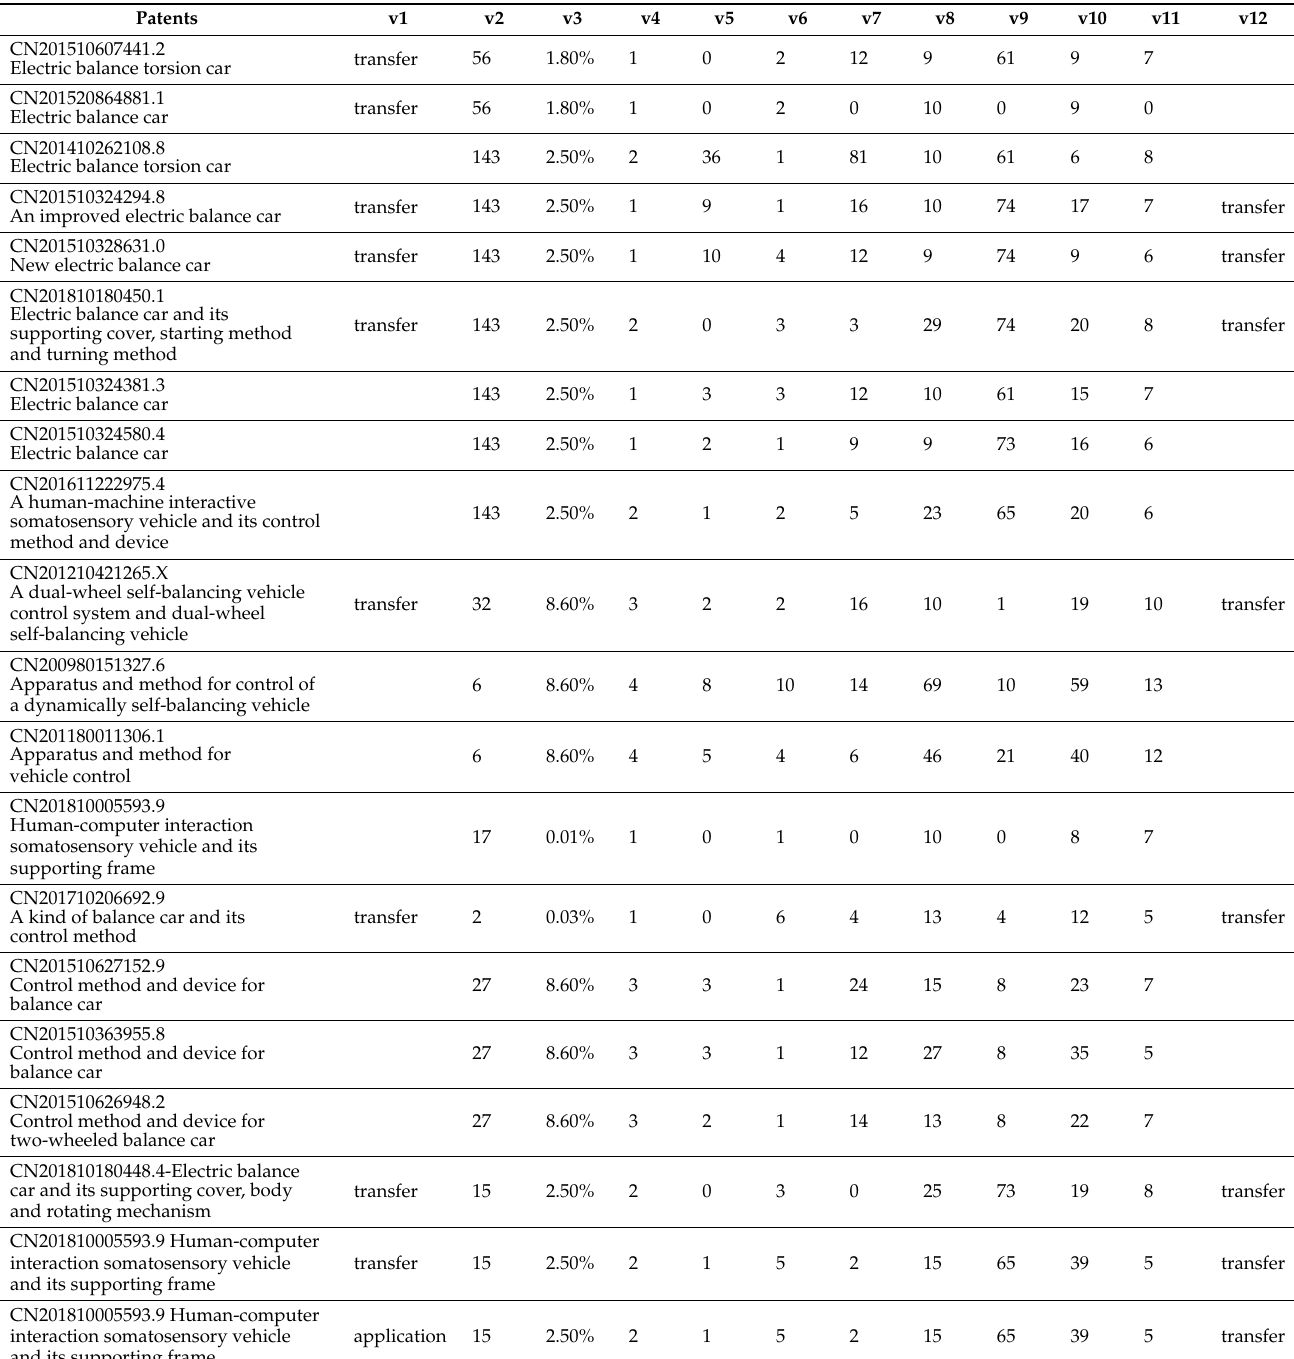
Table 14. Original Attribute Data Matrix of Balance Vehicle